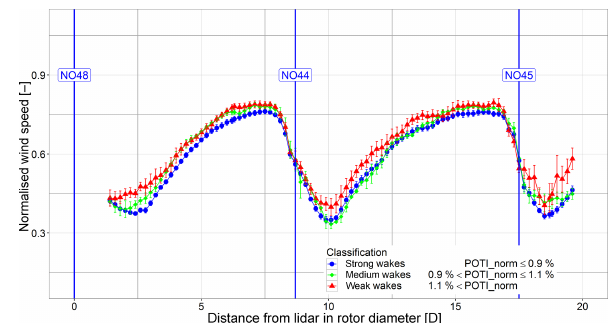
Figure 16. Wind speed recovery behind NO48 for different PO TI classes. The wind speed is normalised with the inflow norm wind speed and the distance from the lidar on NO48 downstream is displayed in multiples of rotor diameters.